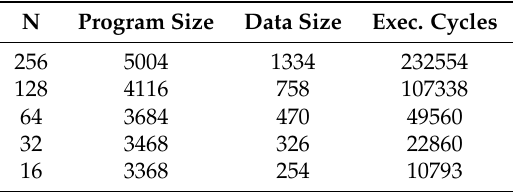
Table 7. Resources for computing the FFT algorithm given in